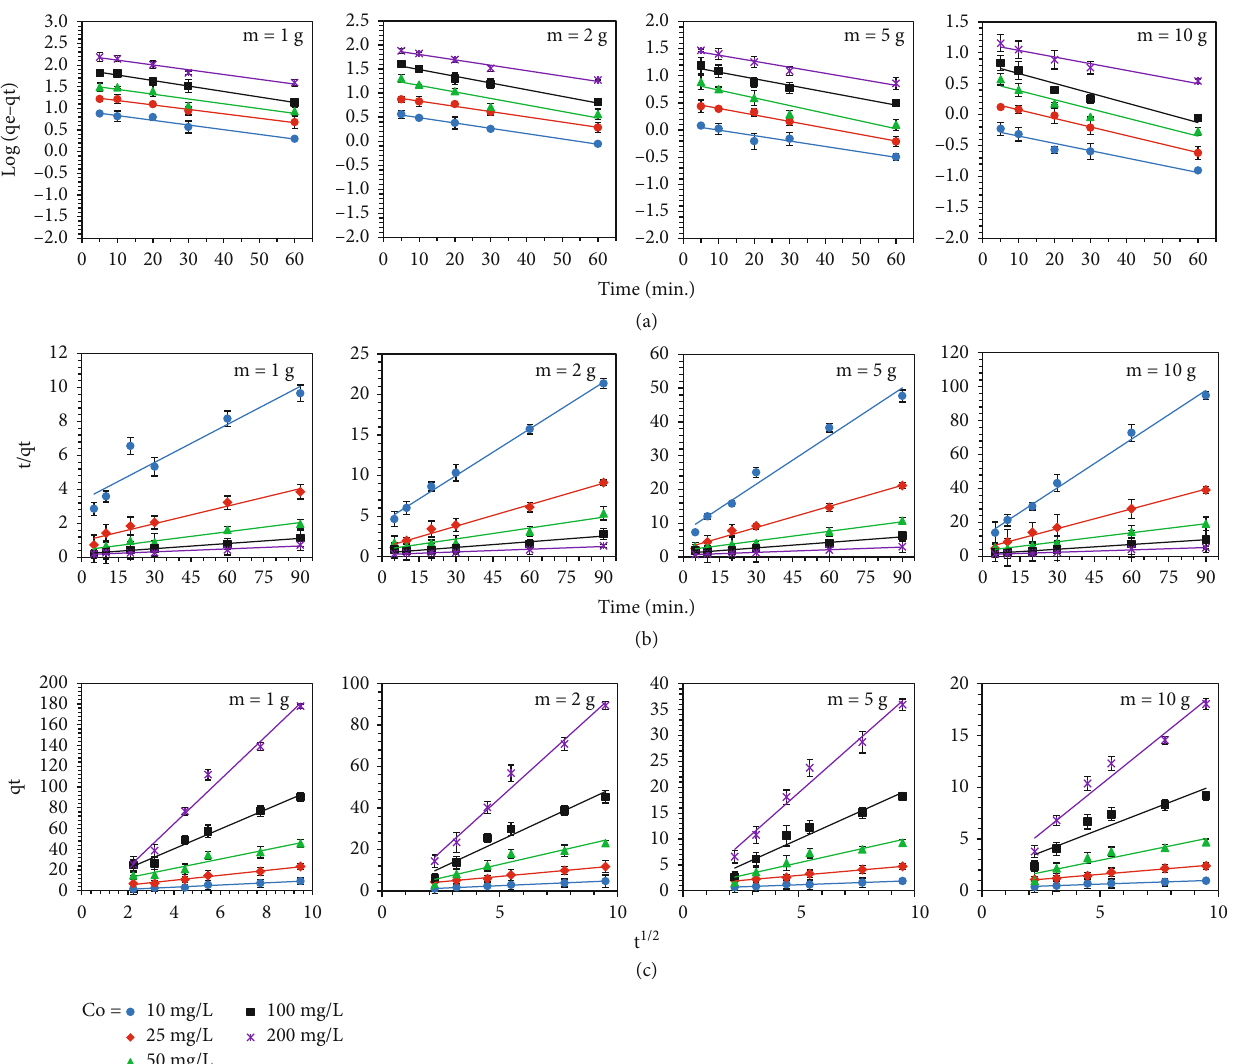
Figure 8: Pseudo- fi rst-order (a), pseudo-second-order (b), and intraparticle (c) kinetic model plots at 35 ° C, pH 5, and 200rpm operating conditions for MBS. ± SD shown by error